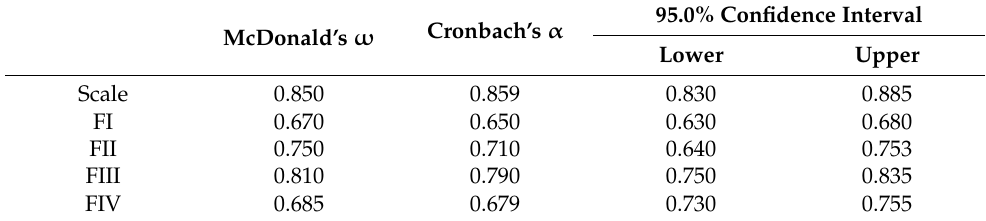
Table 2. Scale reliability statistic.